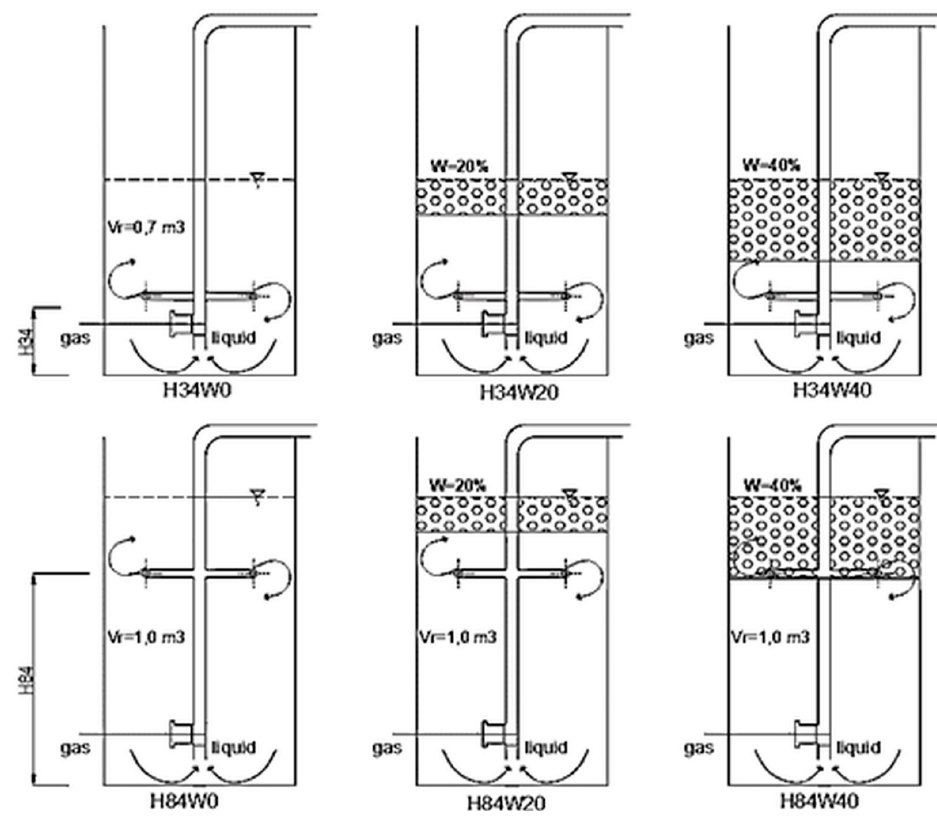
Figure 2. Structural design variants of a hybrid barbotage reactor.